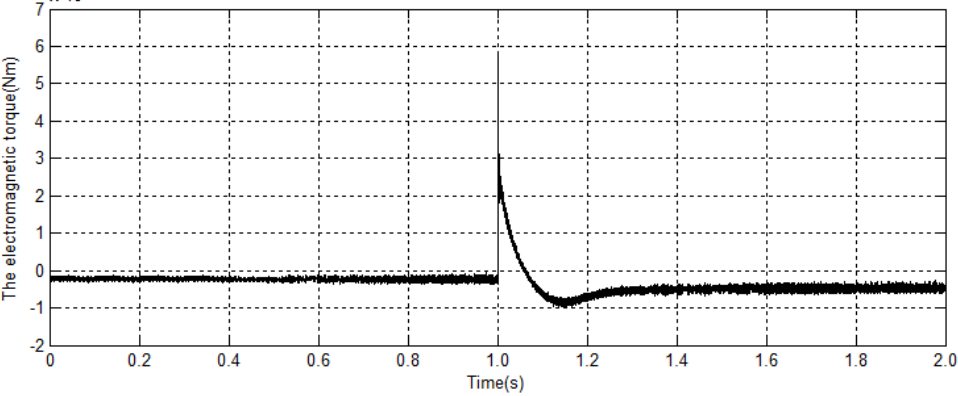
Figure 10. Simulation curve of electromagnetic torque.